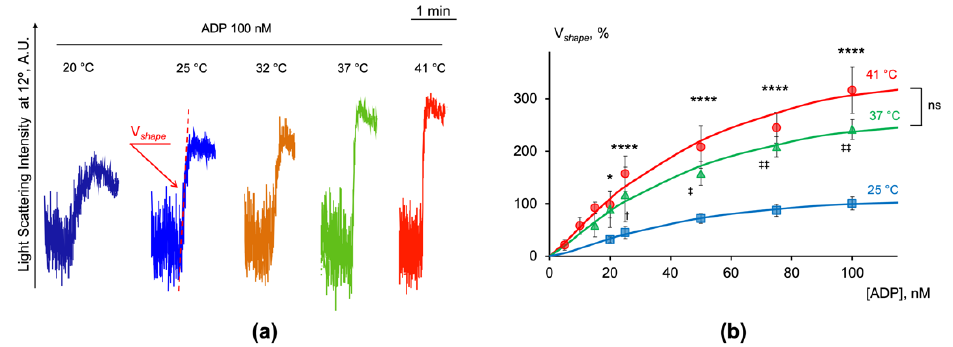
Figure 5. The velocity of shape change reaction gradually increased with the rise in temperature. PRP diluted in HEPES buffer (1 × 10 7 platelets/mL) was added to the cuvette with continuous stirring (1200 rpm) at indicated temperatures. After 2 min of incubation, ADP was added in the concentration range from 5 to 100 nM and the dynamics of the LSI signal changes was monitored at 12°. ( a ) Shown are the original representative traces from four independent experiments; ( b ) the dose-response curves of shape change velocity plotted against ADP concentrations at 25°, 37°, and 41 °C. Points indicate the normalized V shape data, continuous lines represent fits of the Hill equation to the experimental data. Data are presented as means ± SD, one-way ANOVA, Tukey post-hoc, for 41 ° С compared to 25 °C: *, p < 0.05, ****, p < 0.0001; for 37 °C compared to 25 °C: †, p < 0.05, ‡, p = 0.003, ‡‡, p < 0.0001; ns, not significant; n = 4. Table 1. Calculated values of the maximal velocity of platelet shape change (V shape max ), EC 50 , Hill coefficient (h), and τ 1/2 at 25 ◦ C, 37 ◦ C, and 41 ◦